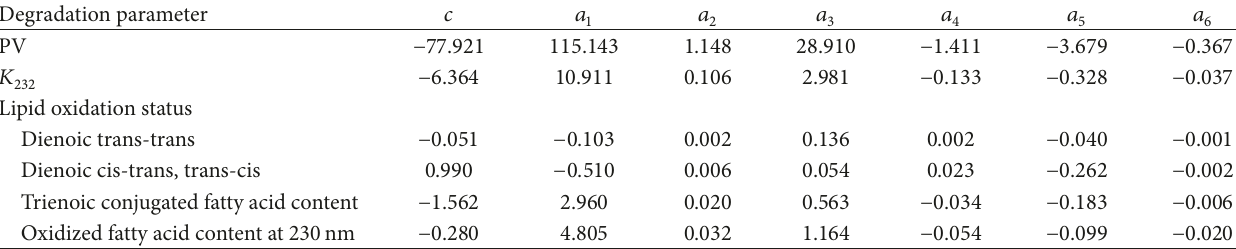
Table 5: Constant values of selected degradation parameters for empirical polynomial models by Zanoni et al. (2005) [10]. Degradation parameter